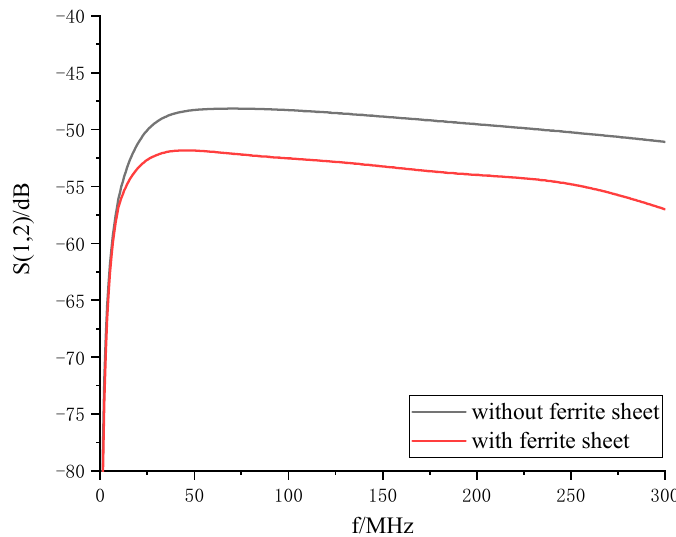
Figure 13. Probe frequency characteristics with and without Ni-Zn ferrite.